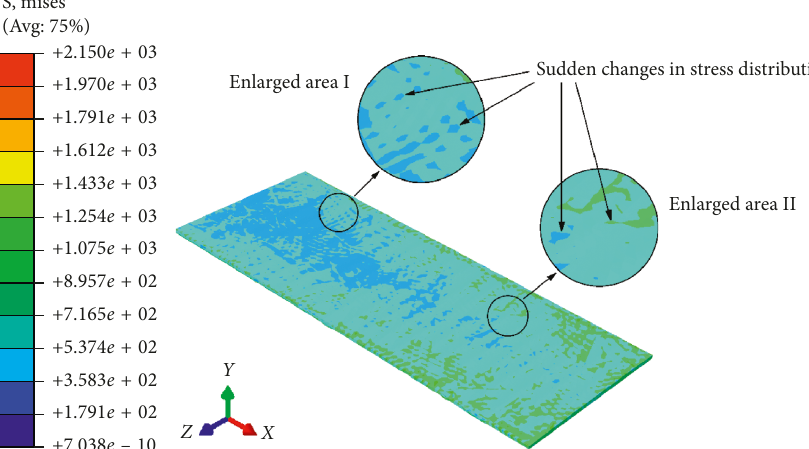
Figure 8: Distribution of effective stress in the microflexible rolled 304 stainless steel specimen S I: thicker thickness area with 5% reduction; enlarged area II: thinner thickness area with 10%